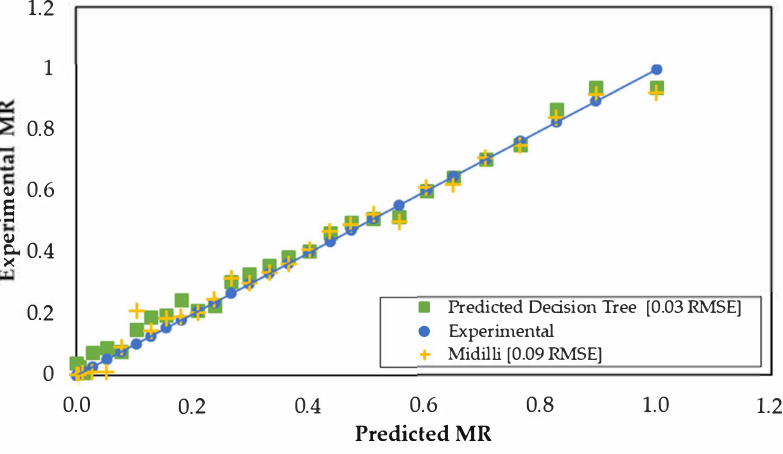
Figure 10. Experimental and predictive MR